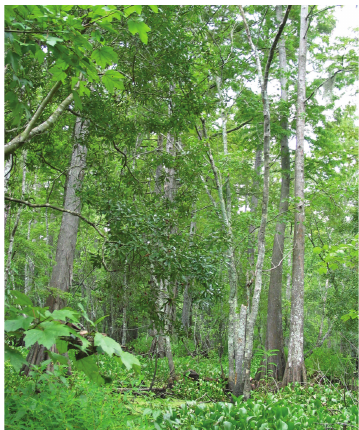
Figure 2: Cypress-tupelo swamp north of Gramercy, Ascension Parish, Louisiana. Figure 3: Cypress-tupelo swamp in Jean Lafitte National Historical Park and Preserve, Je ff erson Parish,